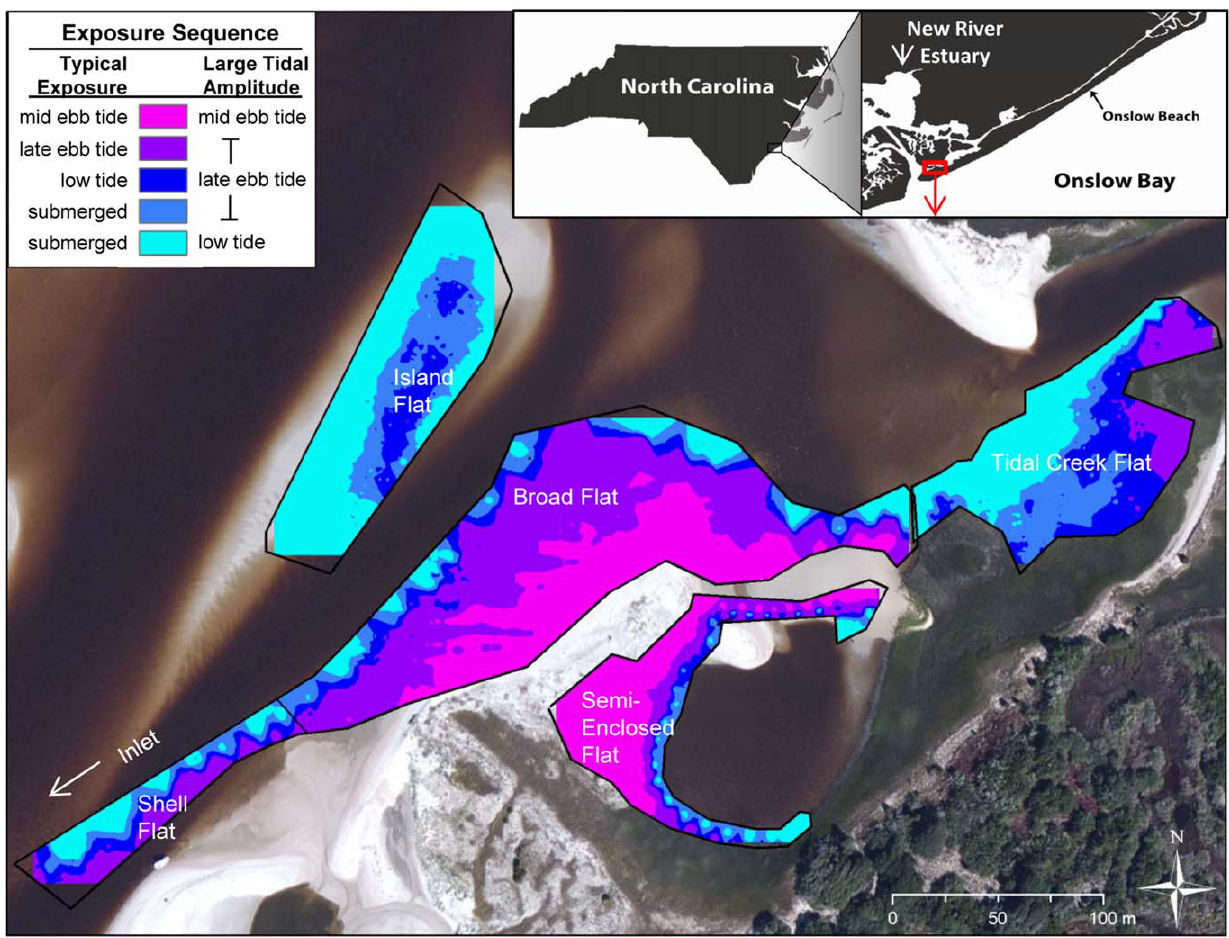
Figure 1. Location and elevation map of study site. (Note: apparent crenulations of the water edge on Broad and Semi-Enclosed Flats are artifacts of the elevation measurement technique.) Base layer photograph from Bing Maps Aerial Imagery.